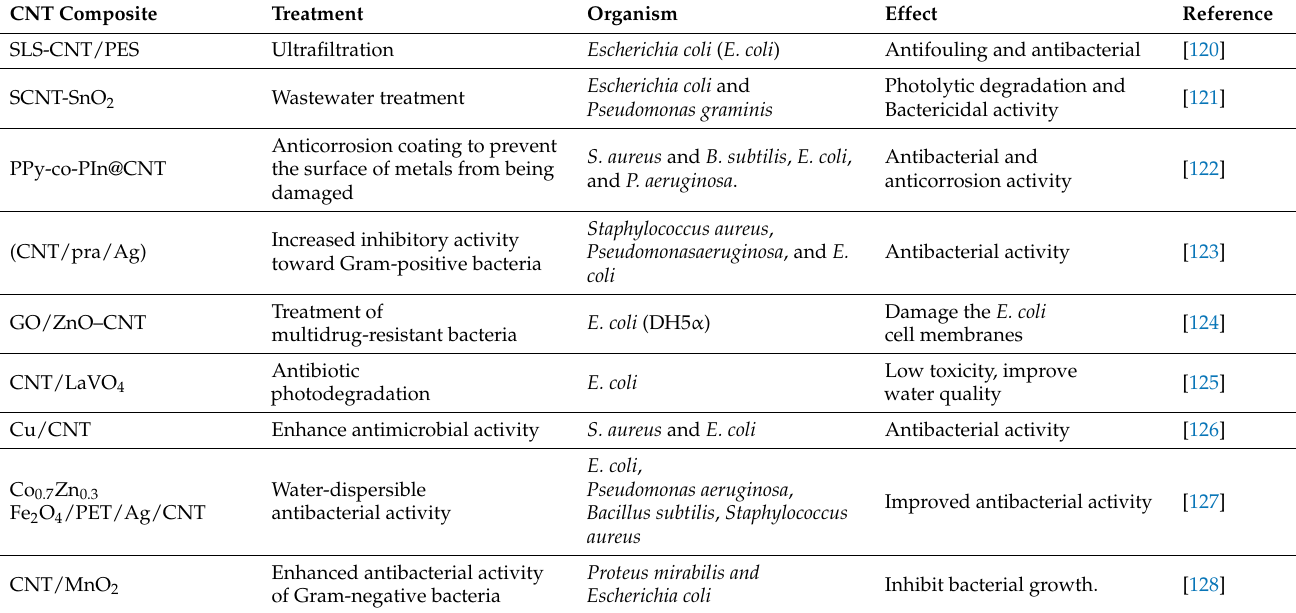
Table 3. Application and aspect of CNT-based composites for antibacterial activity on various